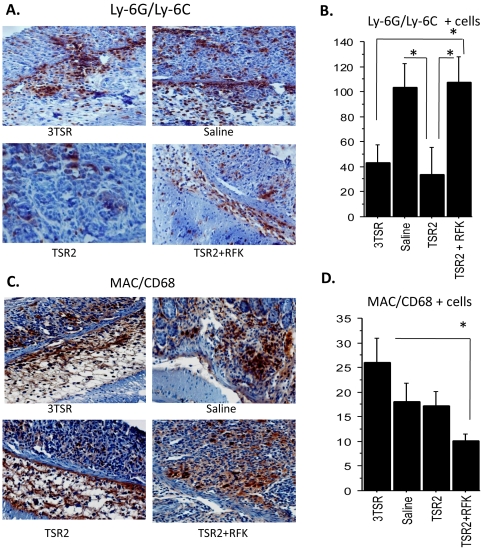
Immunohistochemistry (IHC) with the Ly-6G/Ly-6C antibody for detection of granulocytes and monocytes in colitic sections.Counts of Ly-6G/Ly-6C positive cells in TSR2 and 3TSR were considerably lower than in saline (n = 5 in each group) and TSR2+RFK-treated (n = 9) colons (A). However, only TSR2 showed lower counts that were statistically significant, p = 0.047 (B). IHC against Mac/CD68 (C) showed fewer CD68 positive cells (macrophages) in TSR2+RFK (n = 24) compared to TSR2 (n = 14) and saline (n = 18). These differences were statistically significant, p = 0.0006, when compared with 3TSR-treated (n = 18) colons (D). 400× magnification.